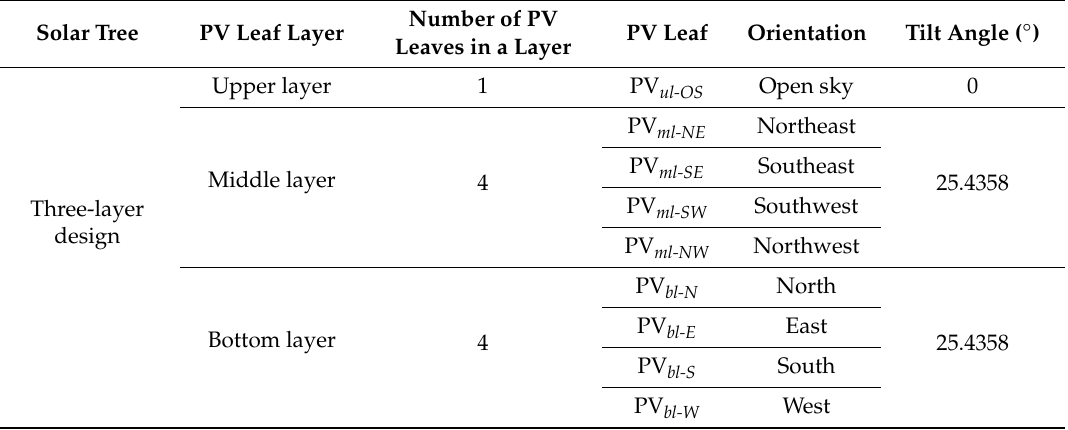
Table 2. Installation configuration of photovoltaic leaves in the three-layered solar photovoltaic tree. Solar Tree